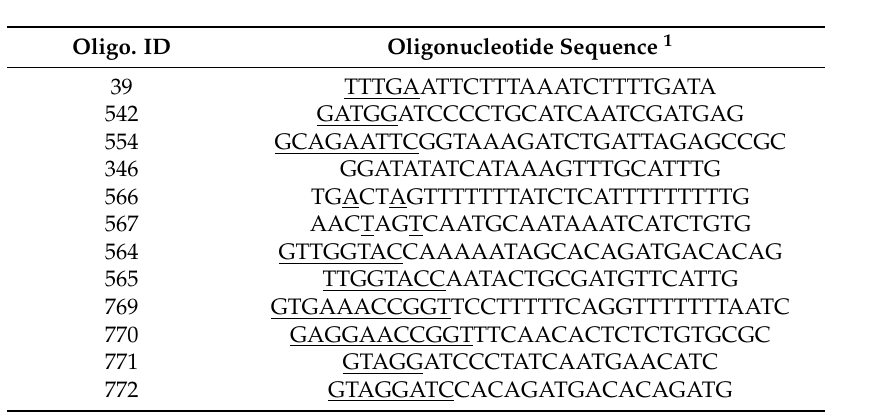
Table 2. Oligonucleotide